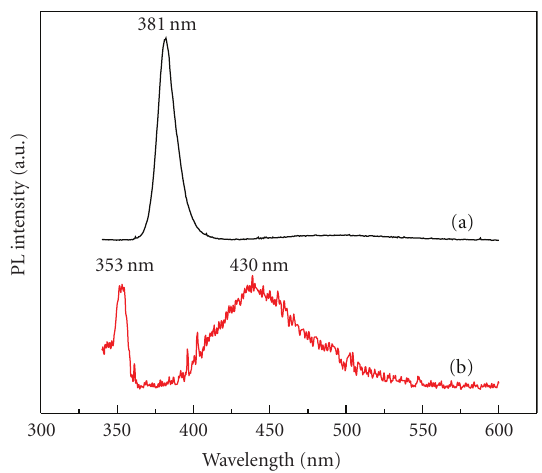
Figure 5: Room-temperature photoluminescence spectra of ZnO nanorods. Curve (a): CVD grown sample, curve (b): CBD grown sample.